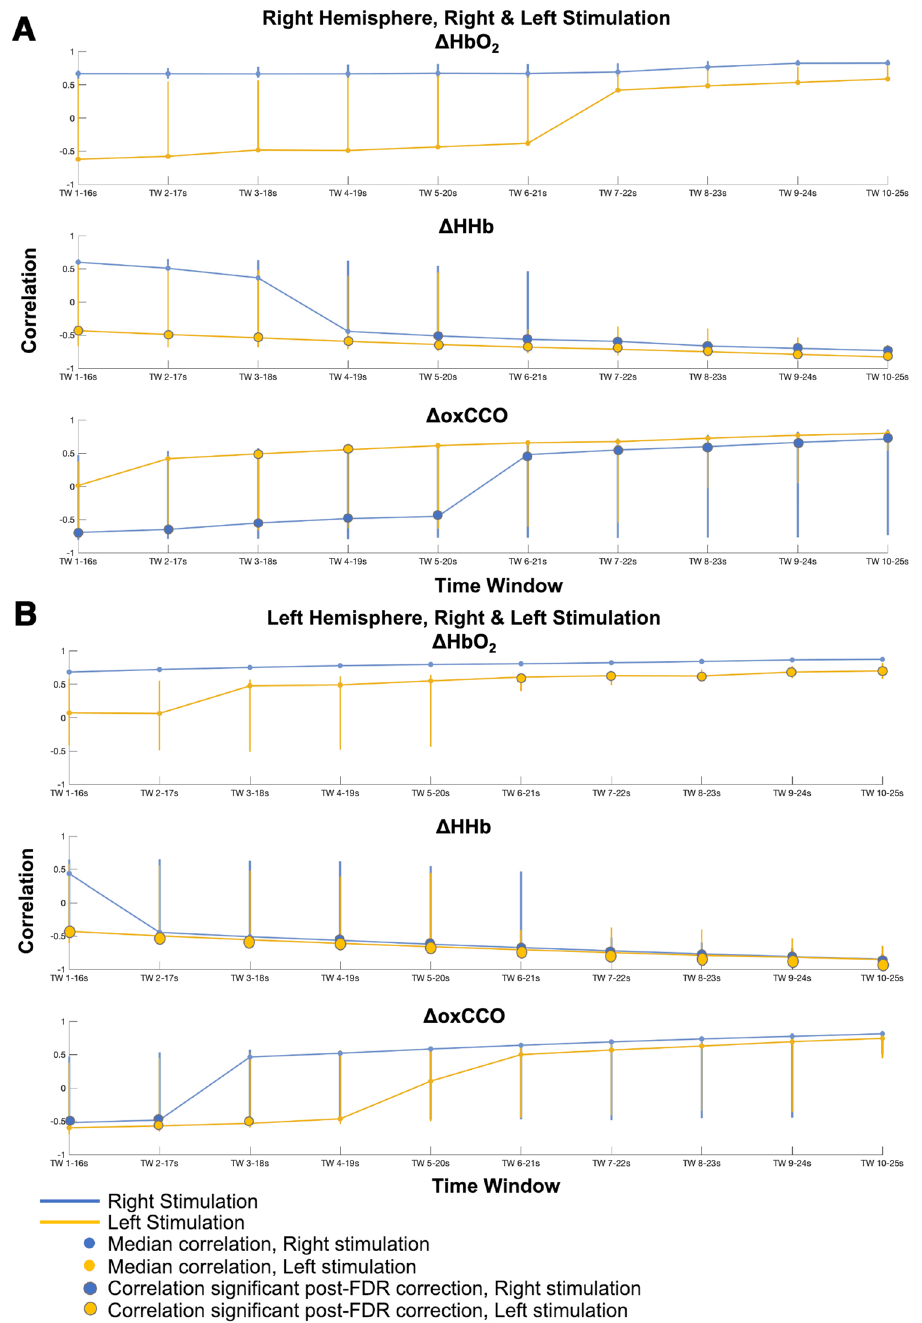
Figure 7. Median cross-correlations between EEG and bNIRS signals, across EEG channels, across bNIRS channels over the right and left hemispheres for all time windows from 1–16 to 10–25 s. ( A ) Median cross- correlations for Right and Left stimulations over bNIRS channels the right hemisphere, for all time windows. ( B ) Median cross-correlations for Right and Left stimulations over bNIRS channels the left hemisphere, for all time windows. The median value is shown and the lines represent minimum and maximum correlations at each time window. The correlations that were significant post-FDR correction are indicated with a larger, solid